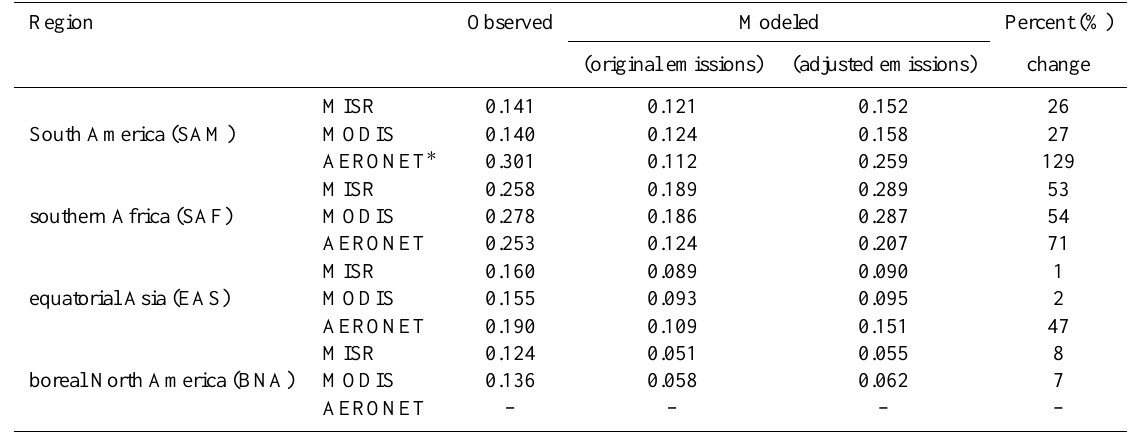
Table 3. Comparison of optical depths from simulations with original and adjusted GFEDv3 emissions.